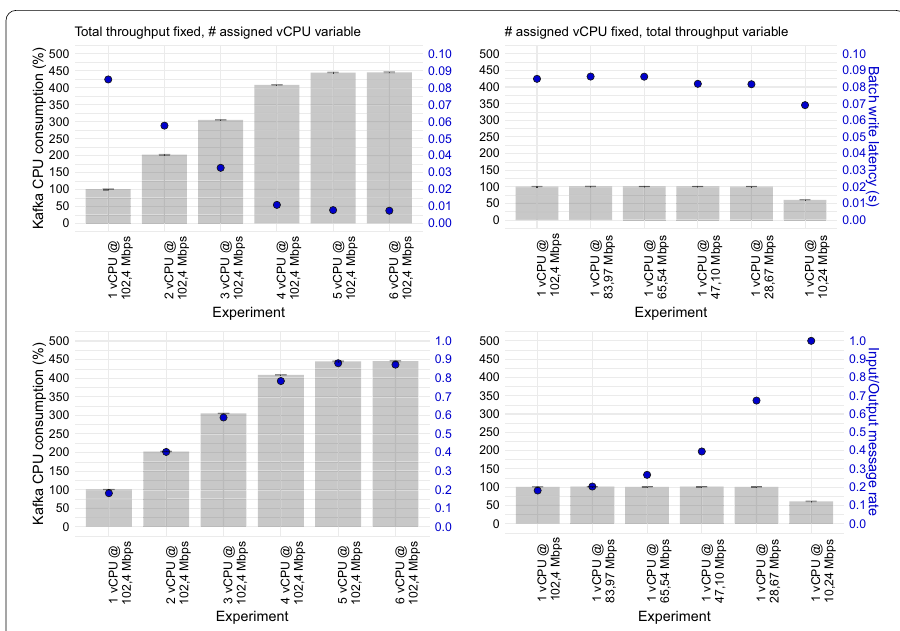
Fig. 8 Effect of saturation in performance parameters when limiting Kafka vCPU allocated in different